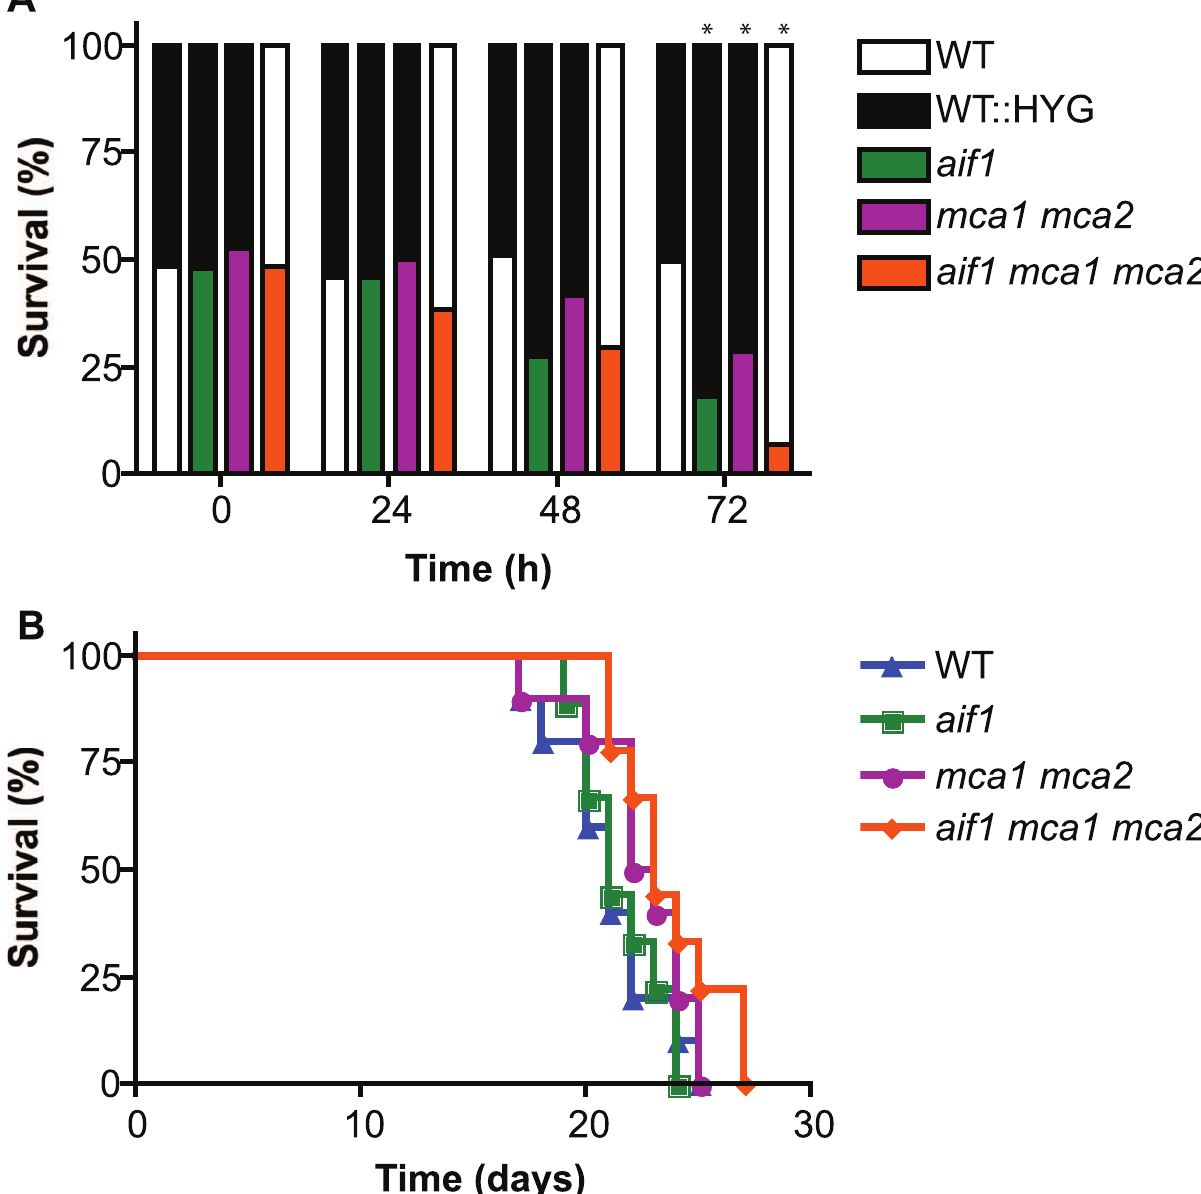
Figure 7. Apoptosis-like cell death is important for competitive fitness. A . Competition assays showing that ALCD is important to population fitness in vitro. Strains H99 and CPS76 (H99 HYG), H99 and CPS3, H99 and YPH104, and H99 and CPS89 were paired at the same cell density and each mixture was inoculated into YPD liquid medium at a final density of 8 6 10 4 cells/ml and incubated at 30 u C for the indicated times. An aliquot of each culture was plated on YPD solid medium, and incubated for 2 days before it was replica plated onto YPD, YPD-HYG, YPD-NAT, and YPD-NEO media. The ratios of survival for each strain at 0, 24, 48, and 72 h are shown for one representative of three experiments and *indicates significance at p , 0.05. B . Virulence of the apoptotic defective strains in the murine model shows no significant difference to wild-type. Mice were infected intranasally with strains H99, CPS3, YPH104, and CPS89.